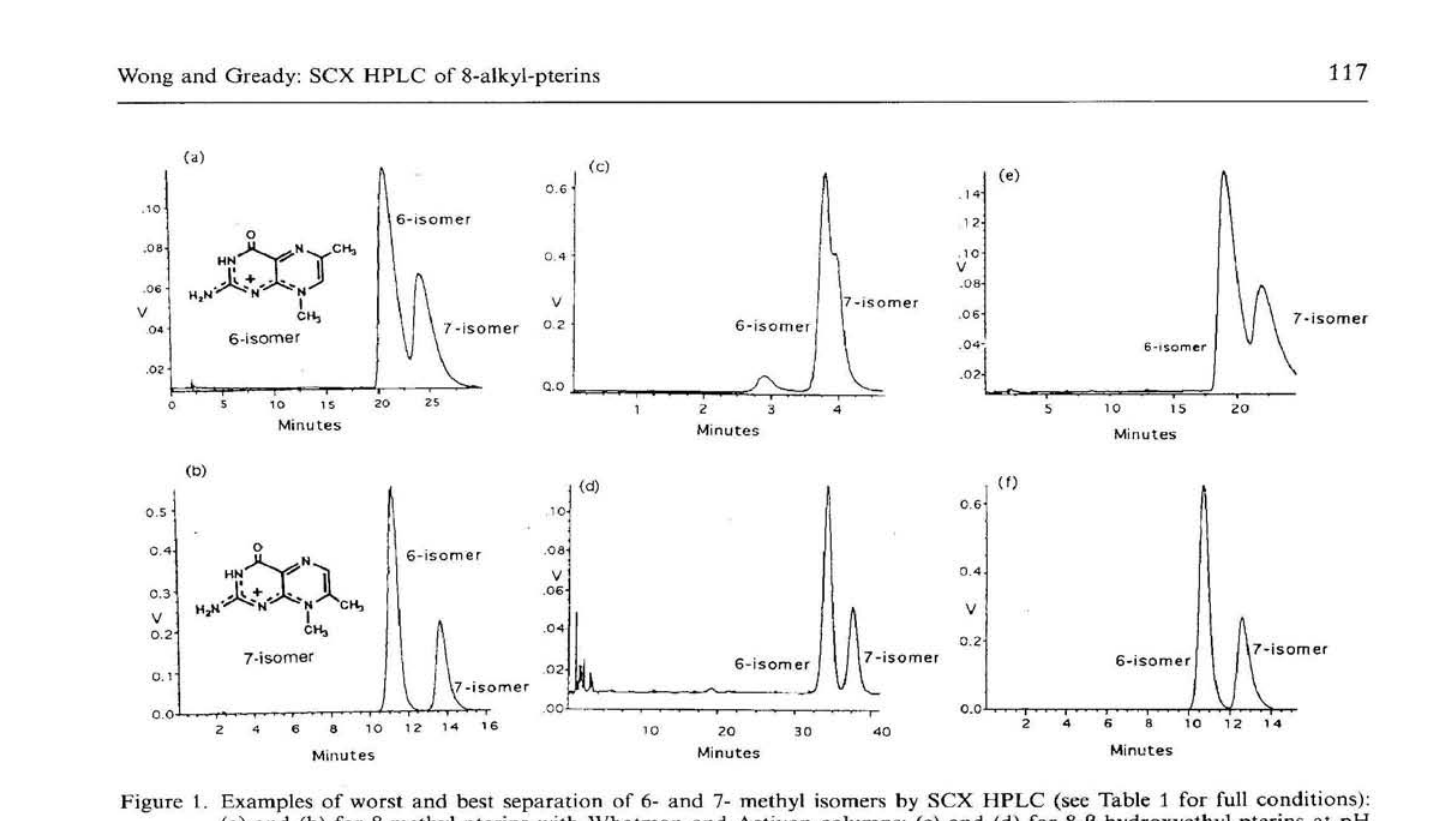
Figure 1. Examples of worst and best separation of 6- and 7- methyl isomers by SCX HPLC (see Table 1 for full conditions): (a) and (b) for 8-methyl-pterins with Whatman and Activon columns; (c) and (d) for 8-ß-hydroxyethyl-pterins at pH 5.5 and 3.3; and (e) and (f) for 8-propyl-pterins at pH 3.3/Whatman and